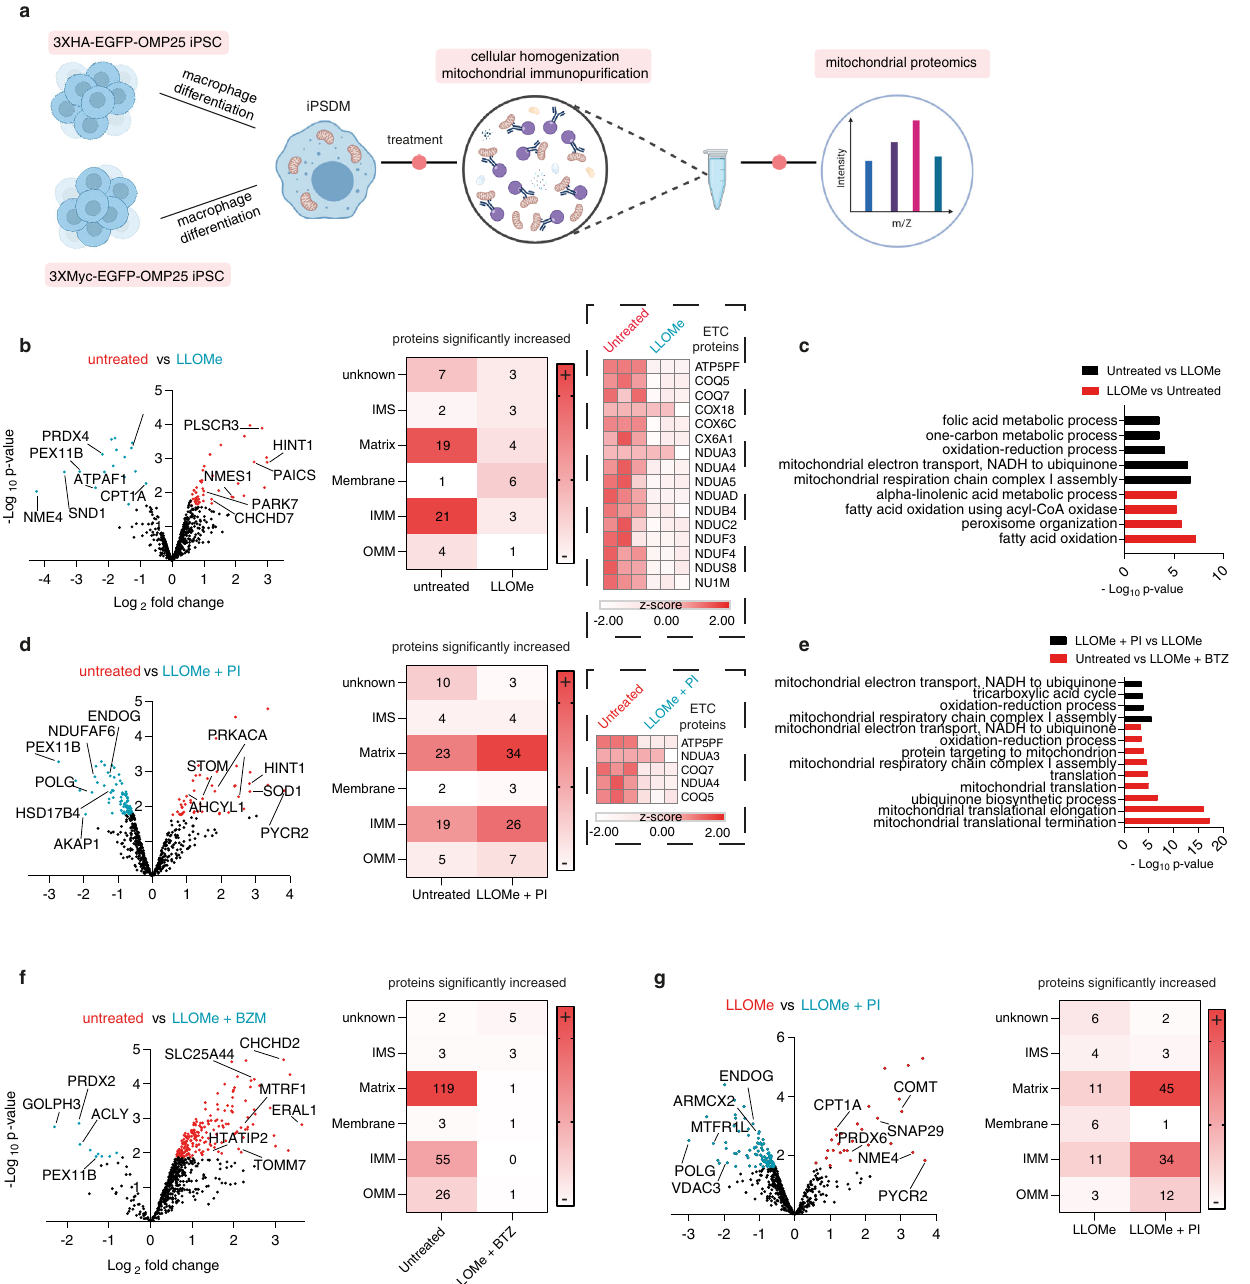
Fig. 2 | Lysosomal leakage remodels the mitochondrial proteome in macro- phages. a Schematic showing the MITO-tag work fl ow in iPSDM. b Proteomic ana- lysisofisolatedmitochondriafromMITO-tagiPSDMuntreated(red)ortreatedwith LLOMe (blue). Volcano plot shows proteins with fold change>1.5 and an adjusted p -value ≤ 0.05. The two most upregulated proteins in the OMM, IMM and matrix (Supplementary Data 1) are shown as illustrative example. Heat maps show the mitochondrial localization of the proteins that were signi fi cantly increased in the indicated comparison and ETC proteins signi fi cantly decreased after LLOMe treatmentareshown(dashed box).Annotationswereobtained fromMitoCarta3.0. c Signi fi cantly regulated proteins from the indicated conditions